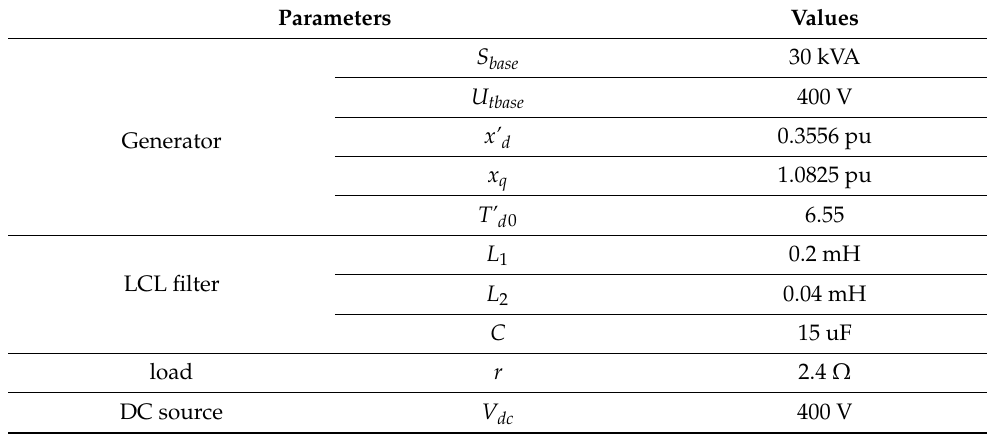
Figure 12. Experiment platform. ( a ) Synchronous generator; ( b ) inverter; ( c ) controller of the inverter. Table 3. The parameters of the experimental platform.